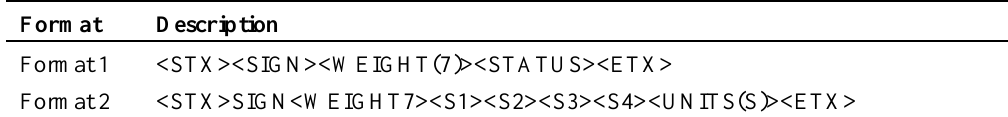
Table 1. Serial Data Format for R320